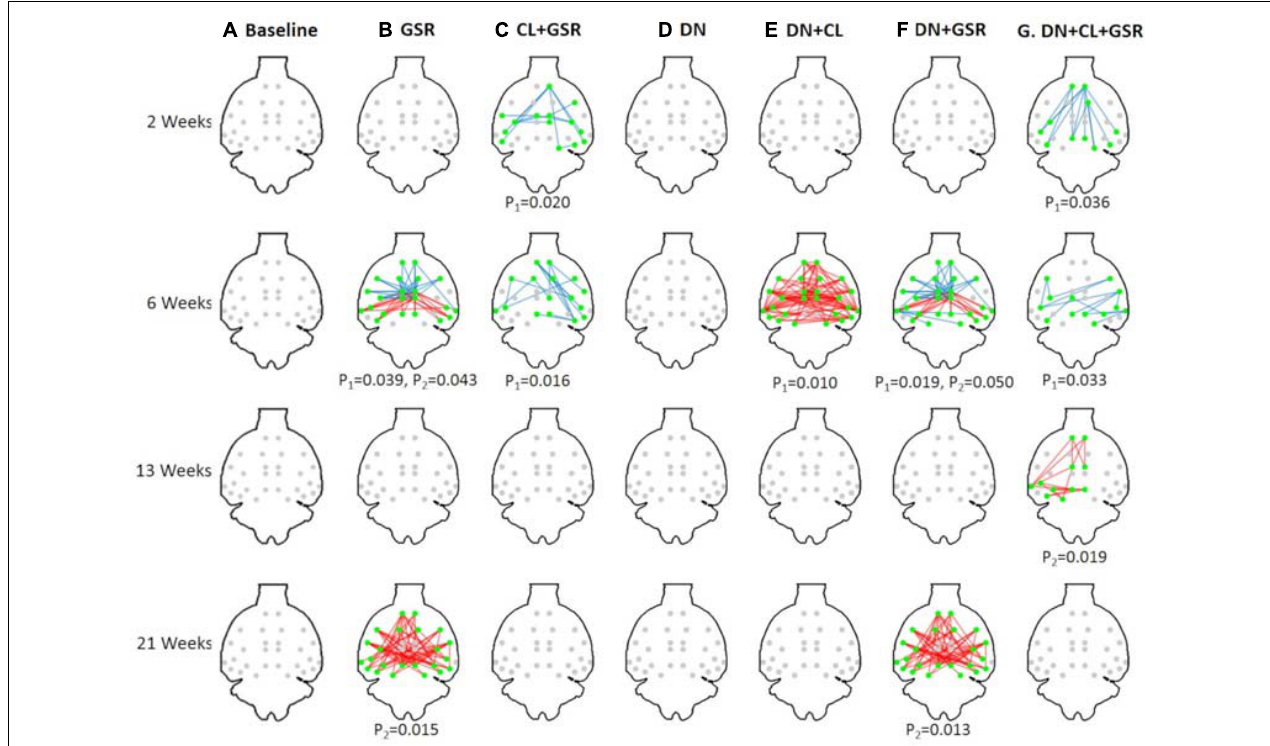
FIGURE 8 | Significant differences in FC between the CTL and STZ groups of Cohort 1 at each timepoint (2, 6, 13, and 21 weeks) for each data processing approach under NBS threshold 2.2. No significant difference was found between the CTL and STZ groups for the baseline pipeline (A) and pipeline (D) (DN only), whereas significant differences were only found at 6 weeks for pipeline (E) (DN + CL, no GSR). Pipelines (B,F) (GSR, or DN + GSR) had similar results with between-group differences detected at 6 and 21 weeks. Pipeline (G) (DN + CL + GSR) most consistently yielded between-group differences across timepoints, whereas pipeline (C) (CL + GSR, no DN) only detected significant differences at two timepoints. Blue edges indicate group differences in contrast 1 ( STZ > CTL ), and red edges indicate group differences in contrast 2 ( STZ < CTL ). p 1 and p 2 are FWER corrected p -values for contrast 1 and contrast 2, respectively. Green nodes indicate ROIs involved in group